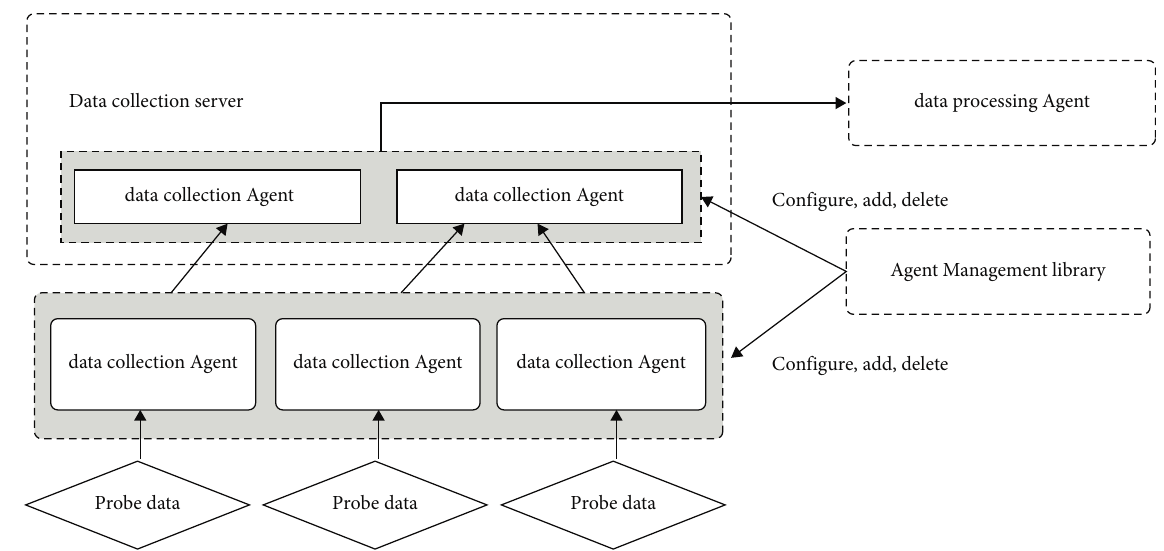
Figure 6: Data collection and processing based on